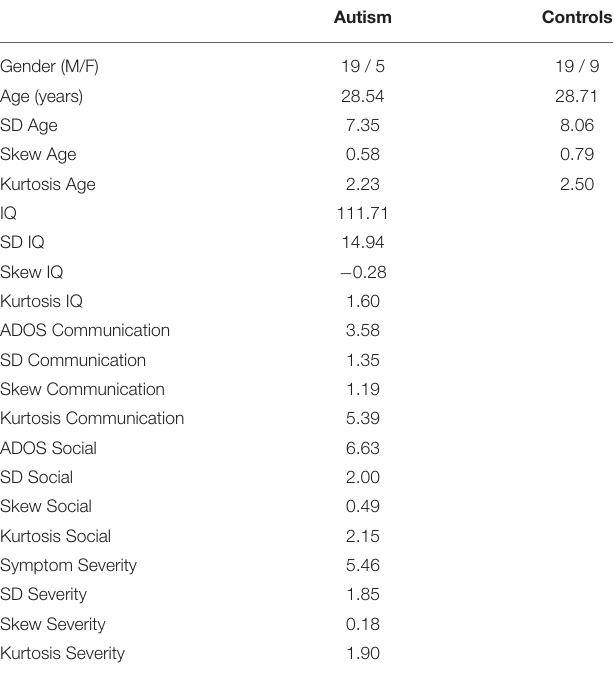
TABLE 1 | Demographic and symptom information for the autism and control groups, showing mean, standard deviation (SD), skewness, and kurtosis for age, IQ, ADOS communication, ADOS reciprocal social interaction, and calibrated symptom severity